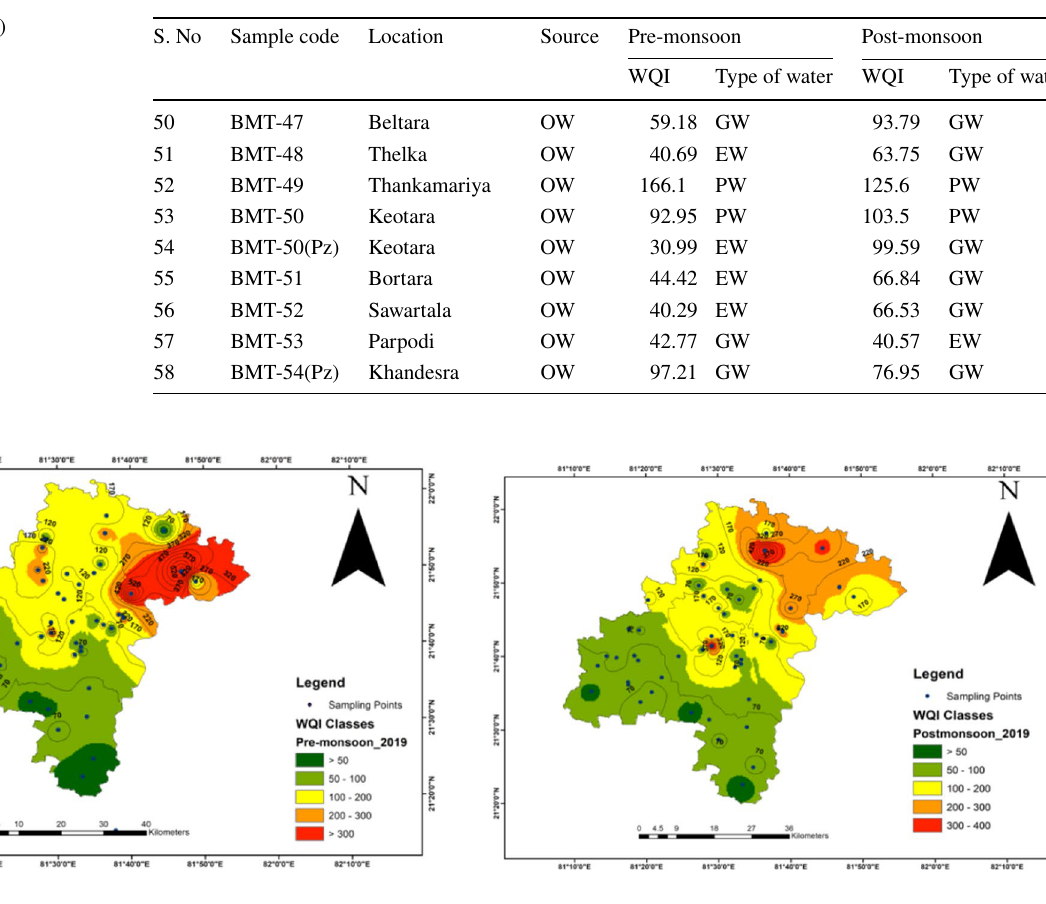
Fig. 9 Spatial distribution of WQI classes for pre- and post-monsoon season (2019) in the study